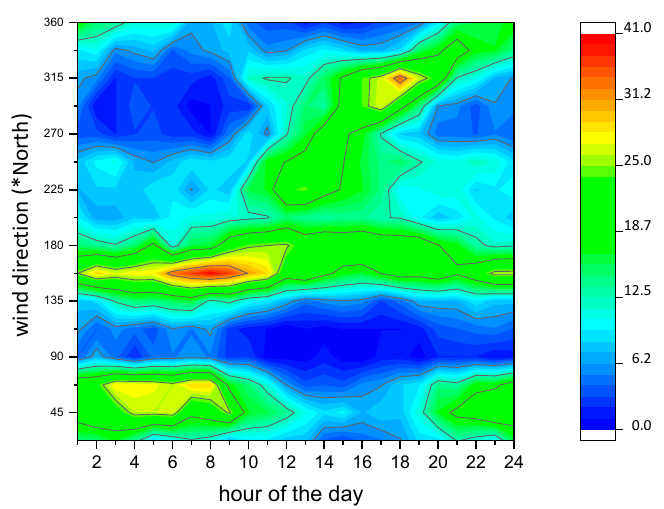
Figure 3. Frequency distribution of wind directions according to the daily hours.